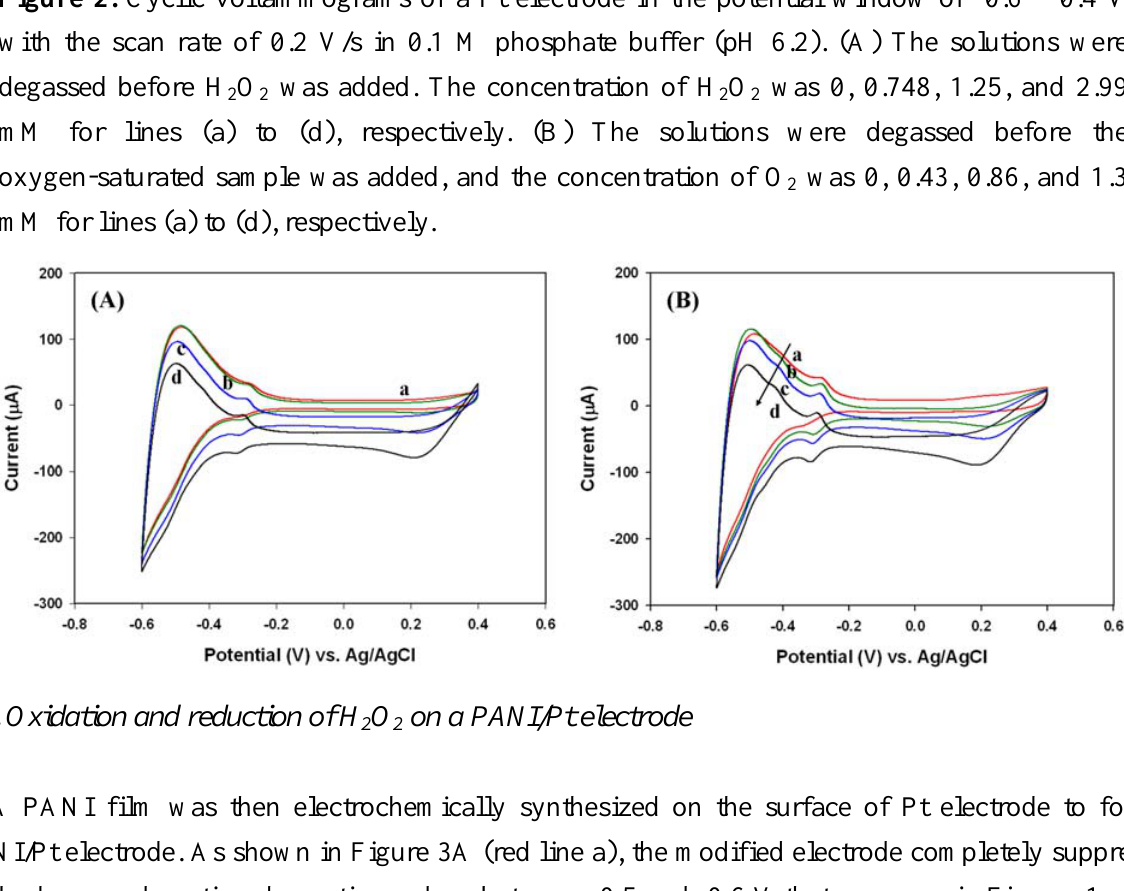
O was 0, 0.748, 1.25, and 2.99 2 2 was 0, 0.43, 0.86, and 1.3 2